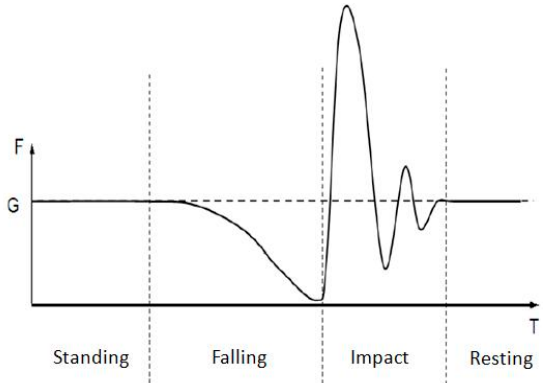
Figure 14. Floor force during the process of falling [47].